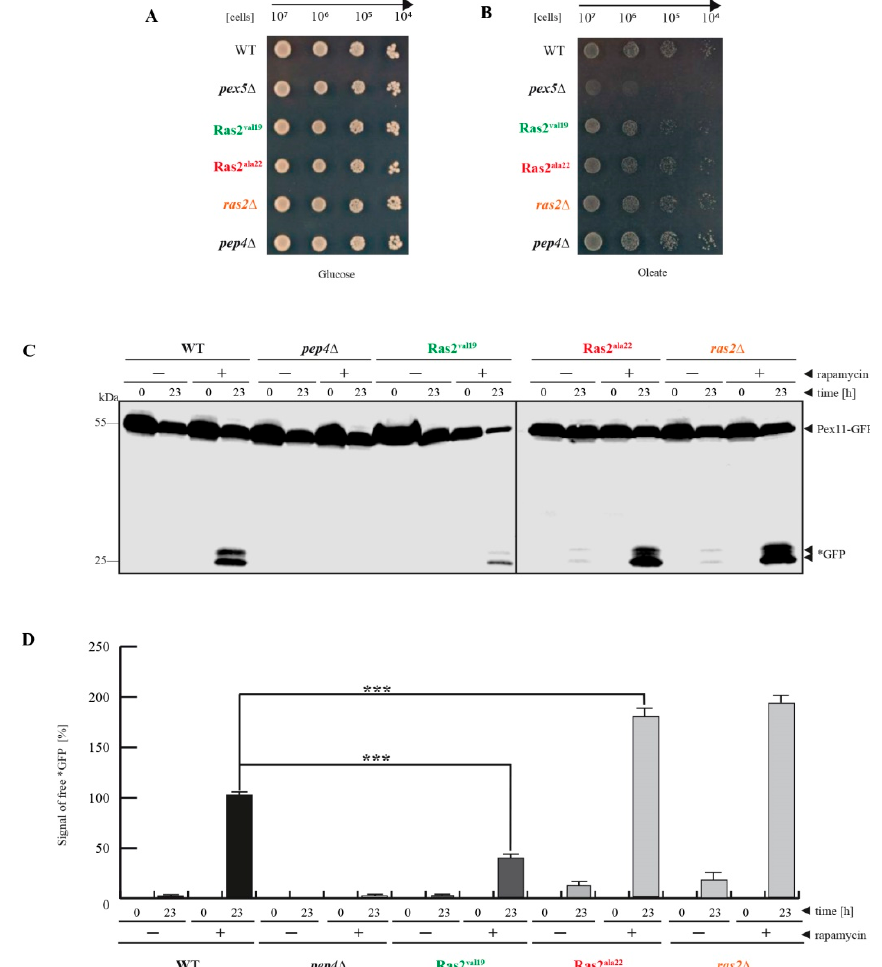
Figure 1. Ras2 ON suppresses rapamycin-triggered peroxisome degradation under bulk autophagy conditions. Series of dilutions of cells from wild-type (WT), pex5 ∆ , Ras2 val19 (Ras2 ON ), Ras2 ala22 (Ras2 OFF ), ras2 ∆ , and pep4 ∆ were spotted on ( A ) glucose and ( B ) oleate plates. All strains grew well on glucose and only the negative-control pex5 ∆ did not grow on oleate, which excludes pleiotropic growth defects or the inhibition of the biogenesis of functional peroxisomes by the Ras2 versions. ( C ) The influence of the Ras2 activity mutants on peroxisome degradation after inhibition of mTOR with rapamycin in glucose-grown cells was monitored via the stability of the peroxisomal membrane protein Pex11, which was genetically fused to GFP (green fluorescent protein). In WT cells, the Pex11-part of the fusion protein is degraded together with the rest of the organelle, while the GFP-portion is largely stable within then vacuole (*GFP). This process is blocked in pep4 ∆ cells, which served as negative control. The amount of free *GFP is reduced in Ras2 ON cells, while it is enhanced in Ras2 OFF cells. ( D ) The *GFP signals were measured via densitometry. The statistical analysis of the data ( n = 5) demonstrates that the amount of generated *GFP is significantly reduced in the Ras2 ON cells and significantly elevated in Ras2 OFF cells when compared to WT (***, p < 0.001). These data strongly indicate that Ras2 supports mTOR in the inhibition of peroxisome degradation in glucose-grown